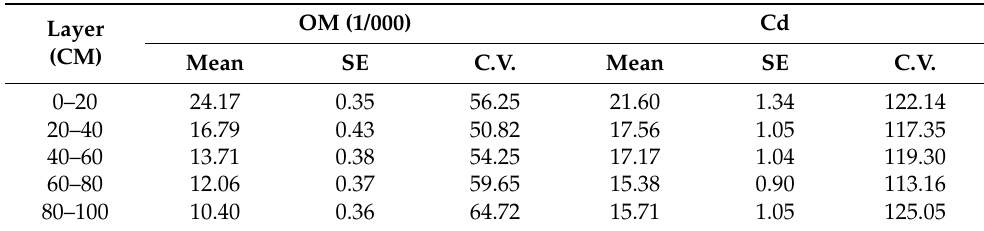
Table 6. Soil organic matter content and Cd